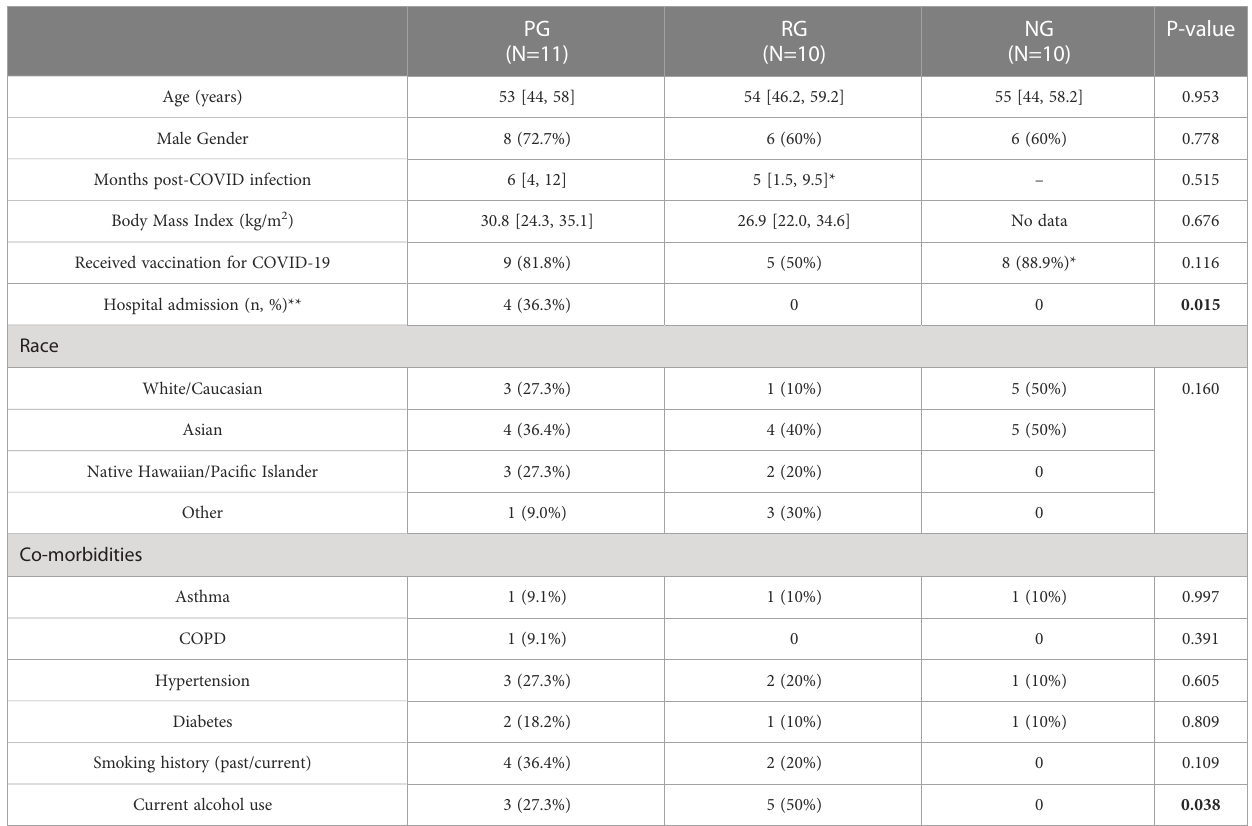
TABLE 1 Characteristics of study